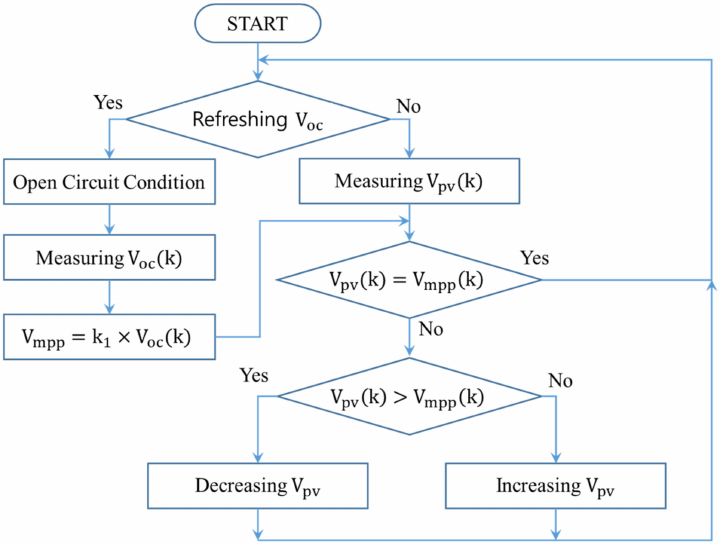
Figure 4. Flowchart of OCV